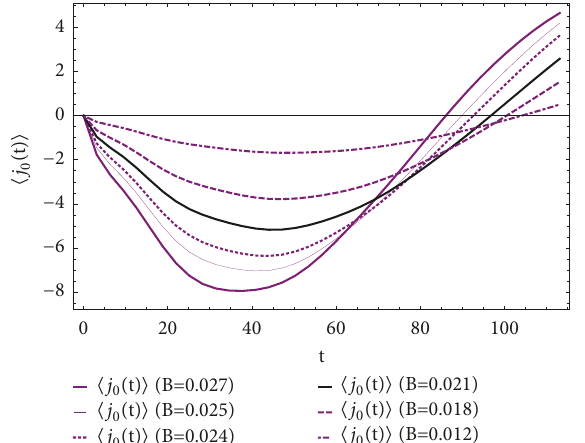
Figure 4: Dependence on the expansion rate 𝐻 푡 of the time 0 evolution of PNA. In the horizontal axis, we use the dimensionless Figure2:Dependenceonparameter 𝐵 ofthetimeevolutionofPNA. time 𝑡 = 𝜔 푟 3, 0 (𝑥 0 − 𝑡 0 ) where we choose 𝜔 푟 3, 0 = 0.35 . We fix a set Thehorizontal axis is thedimensionless time defined as 𝑡 = 𝜔 푟 3, 0 (𝑥 0 − 𝑡 ) . As a reference angular frequency, we choose 𝜔 푟 = 0.35 . We of parameters as ( ̃𝑚 1 , ̃𝑚 2 ,𝐵, 𝑇,𝜔 3, 0 ) = ( 0.04,0.05,0.021,100,0.0035 ) 0 3, 0 , 𝜔 0.05,100,10 −3 ,0.0035 ) for all of the lines. The gray, dashed gray, dotted gray, and black lines fix a set of parameters as ( ̃𝑚 2 ,𝑇,𝐻 푡 3, 0 ) = ( 0 = 0,10 −4 ,5 × 10 −4 and 10 −3 , respectively. show the cases 𝐻 푡 for all of the lines. The purple, thin purple, dotted purple, black, 0 dashed purple, and dot-dashed purple lines show the cases 𝐵 = 0.027,0.025,0.024,0.021,0.018 and 0.012 , respectively. plot, we show the cases that the mass difference ̃𝑚 2 − ̃𝑚 1 is larger than the frequency 𝜔 3, 0 . Since 𝐵 2 , proportional to mass 2 − ̃𝑚 2 squared difference ̃𝑚 2 1 , of the magenta line is smaller than that of the black line, the mass difference ̃𝑚 2 − ̃𝑚 1 of the magenta line is closer to 𝜔 3, 0 . At the beginning ( 0 < 𝑡 < 22 ), the black line of large 𝐵 has the larger amplitude than that of the magenta line of small 𝐵 . At time 𝑡 ∼ 22 , the amplitude of the magenta line becomes larger than that of the black line. We also observed that when the mass difference is near to the 𝜔 3, 0 , that is for the case of magenta line, the amplitude grows slowly compared with that of the black line and reaches